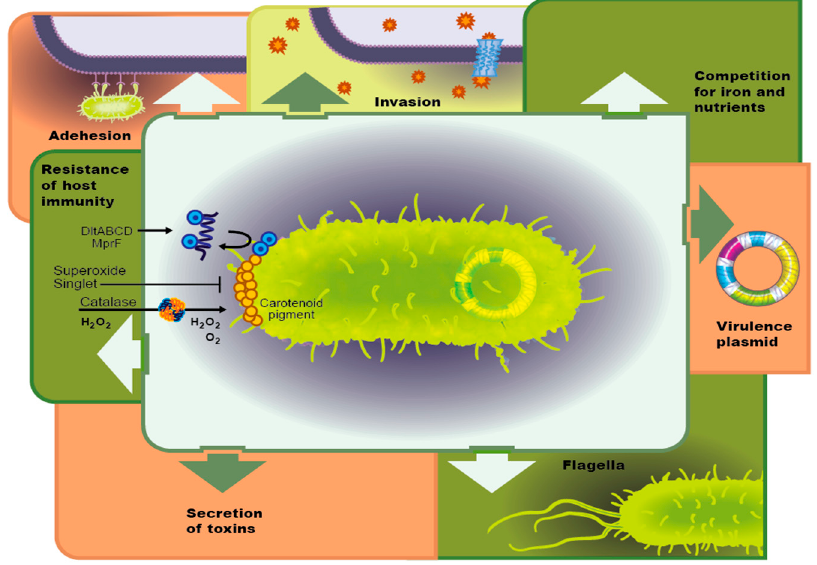
Figure 3. Summary of virulence factors commonly recognized.